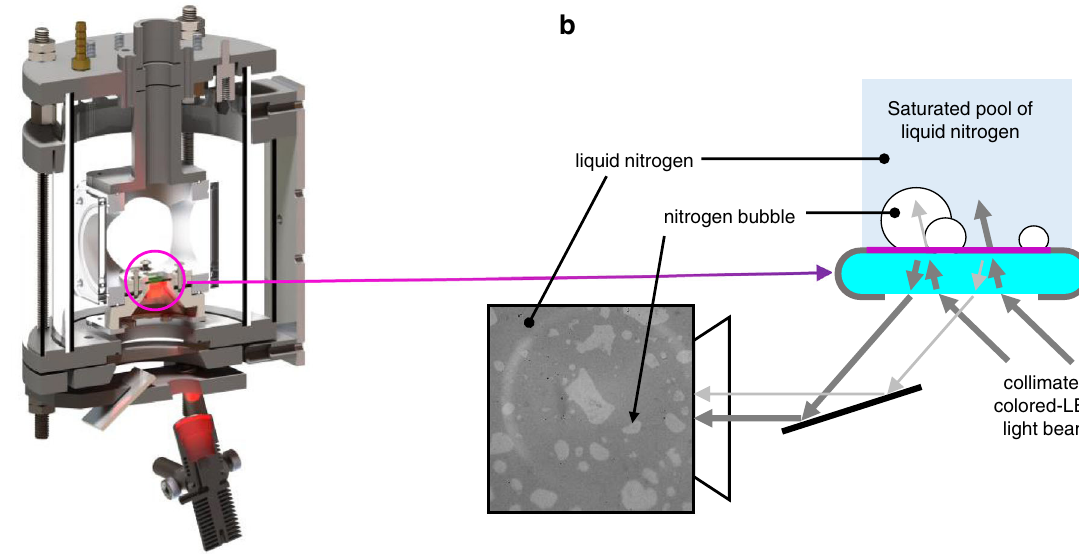
Fig. 6 | Test sections used for cryogenic boiling experiments and phase detection technique. a Cross sectional view of the pool boiling apparatus used for boiling experiments with liquid nitrogen. b Illustration of the phase-detection